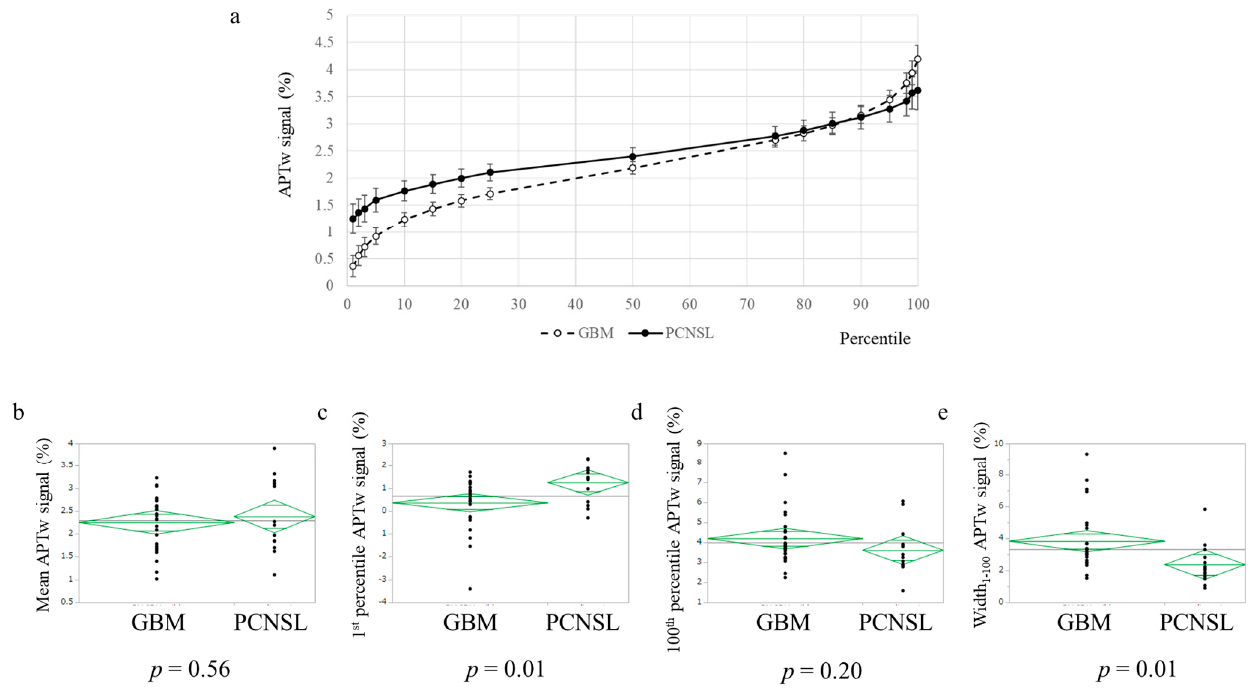
Table 2. The mean, percentile, and width 1–100 APTw signal values of PCNSL and glioblastoma, IDH- wildtype.